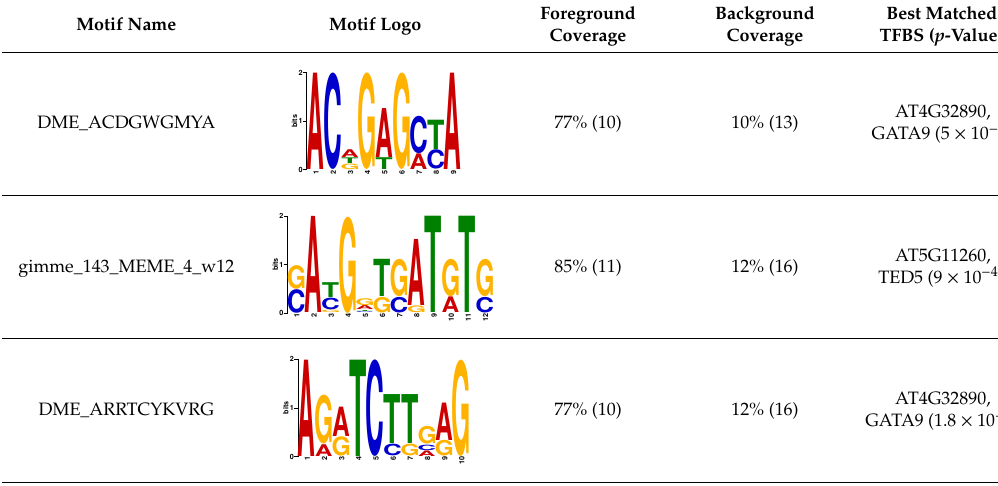
Table 3. Motifs identified in Filter B. The foreground coverage indicates the percentage (and number) of pollen-specific HRGP genes having the identified motif in their promoter regions. The background coverage is the percentage (and number) of the non-pollen HRGP genes having that motif in their promoter regions. The relative frequency is the foreground coverage divided by the background coverage. The matched TFBS p -value is a known transcription factor binding site that relates to pollen along with the accompanying p